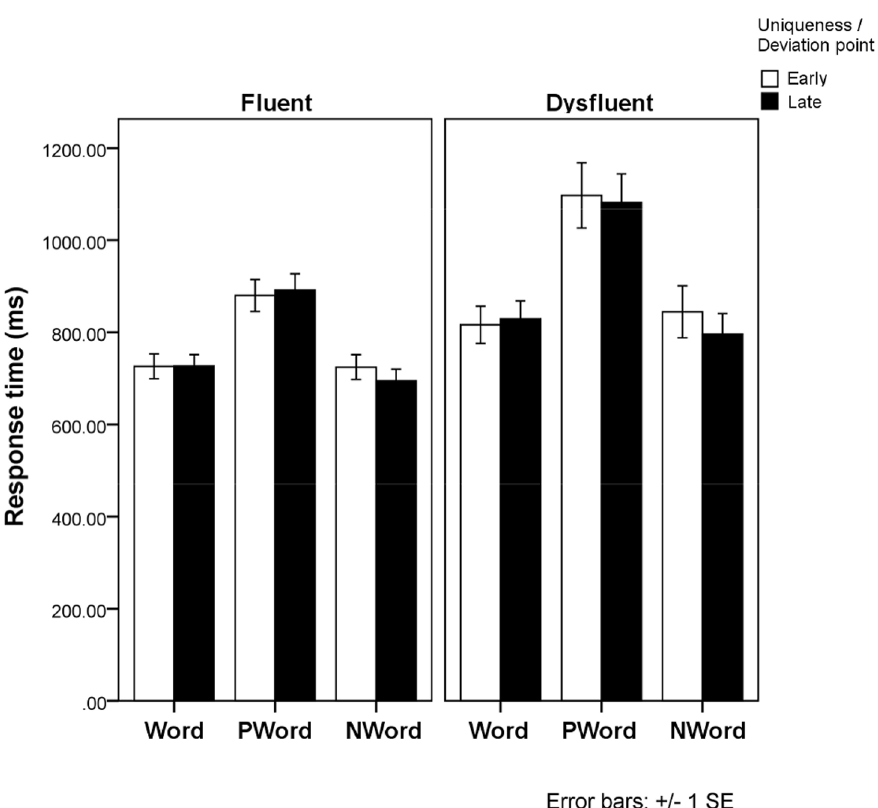
Figure 5. The influence of the word uniqueness point, and the pseudo-word and non-word deviation points, among fluent and dysfluent adult readers on lexical decision response times.